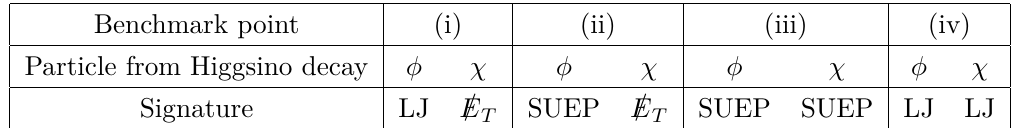
Table 3 . The signatures of χ and φ (from the Higgsino decay) for benchmark points.